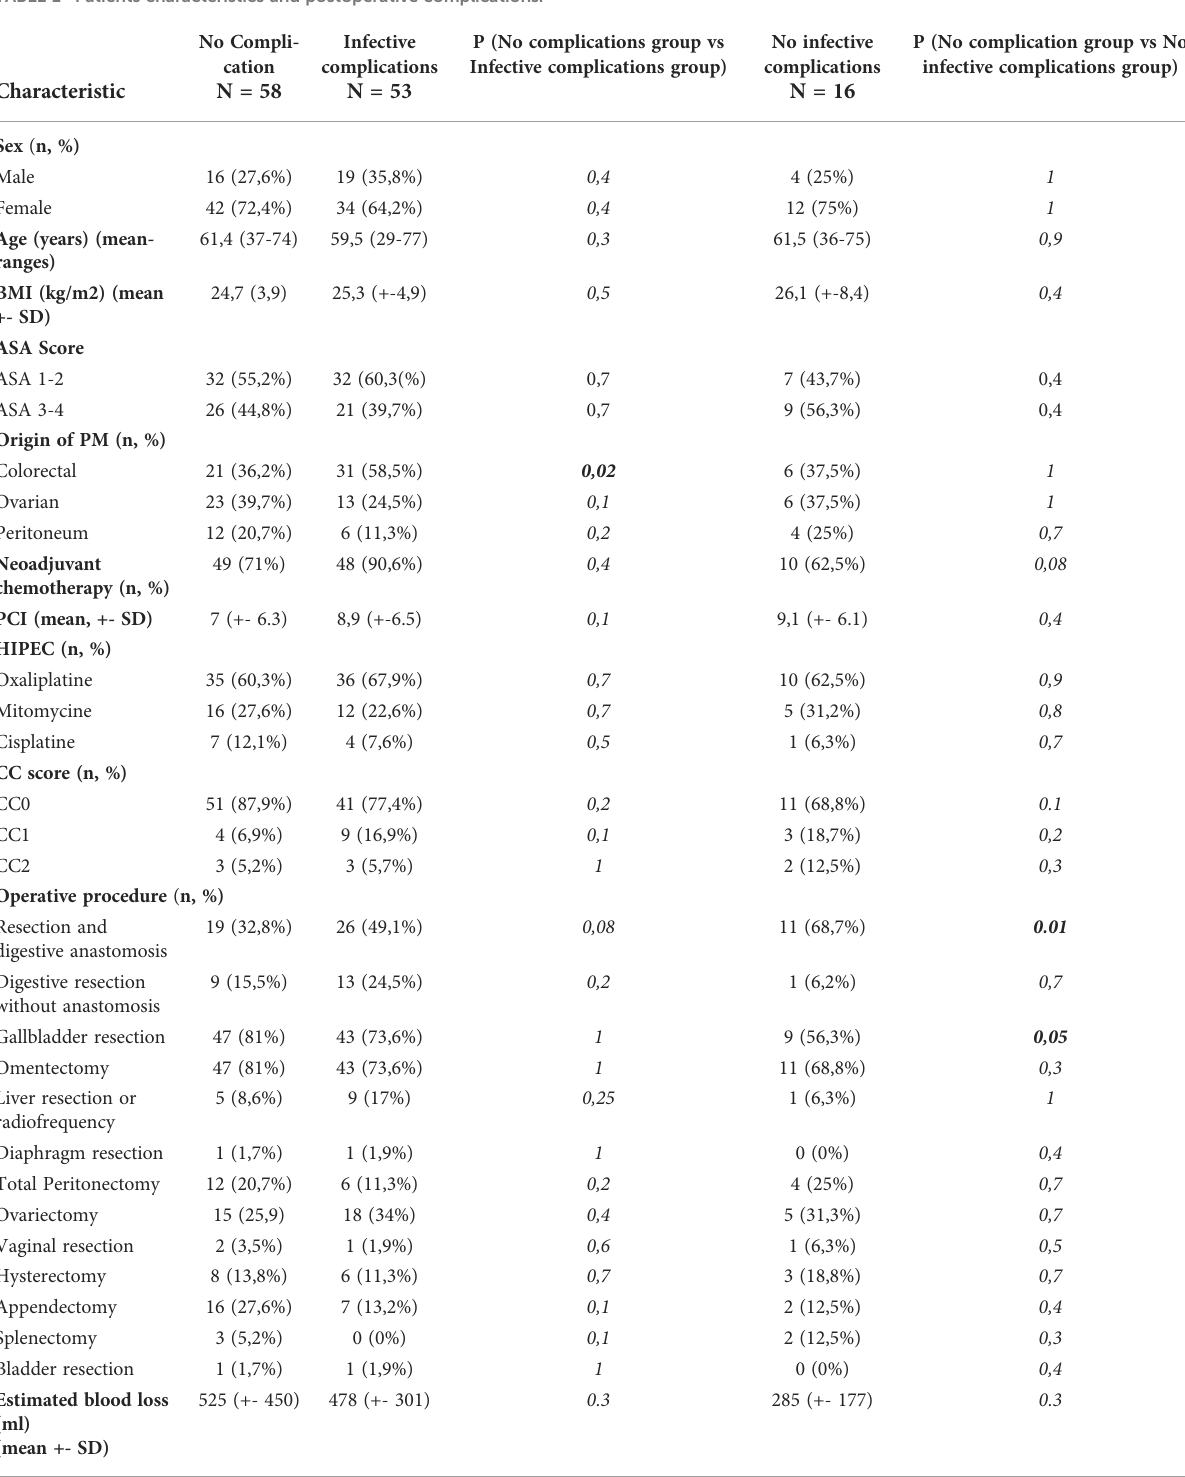
TABLE 1 Patients characteristics and postoperative